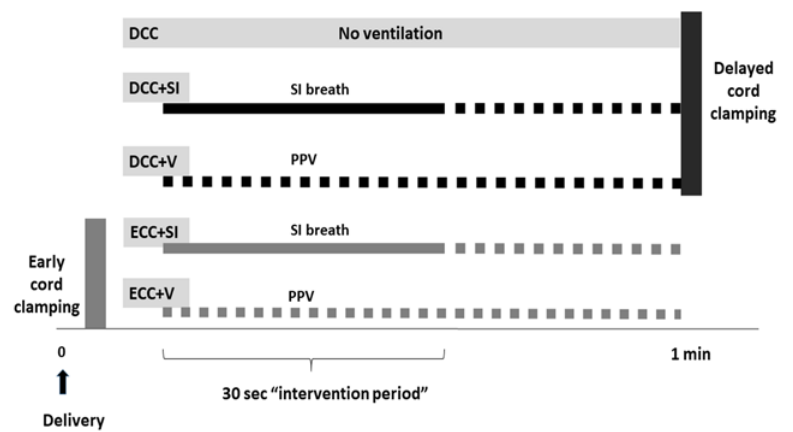
Figure 1. Study groups based on the timing of cord clamping and type of ventilation. DCC: Delayed cord clamping, ECC: Early cord clamping, SI: Sustained inflation, PPV: Positive pressure ventilation